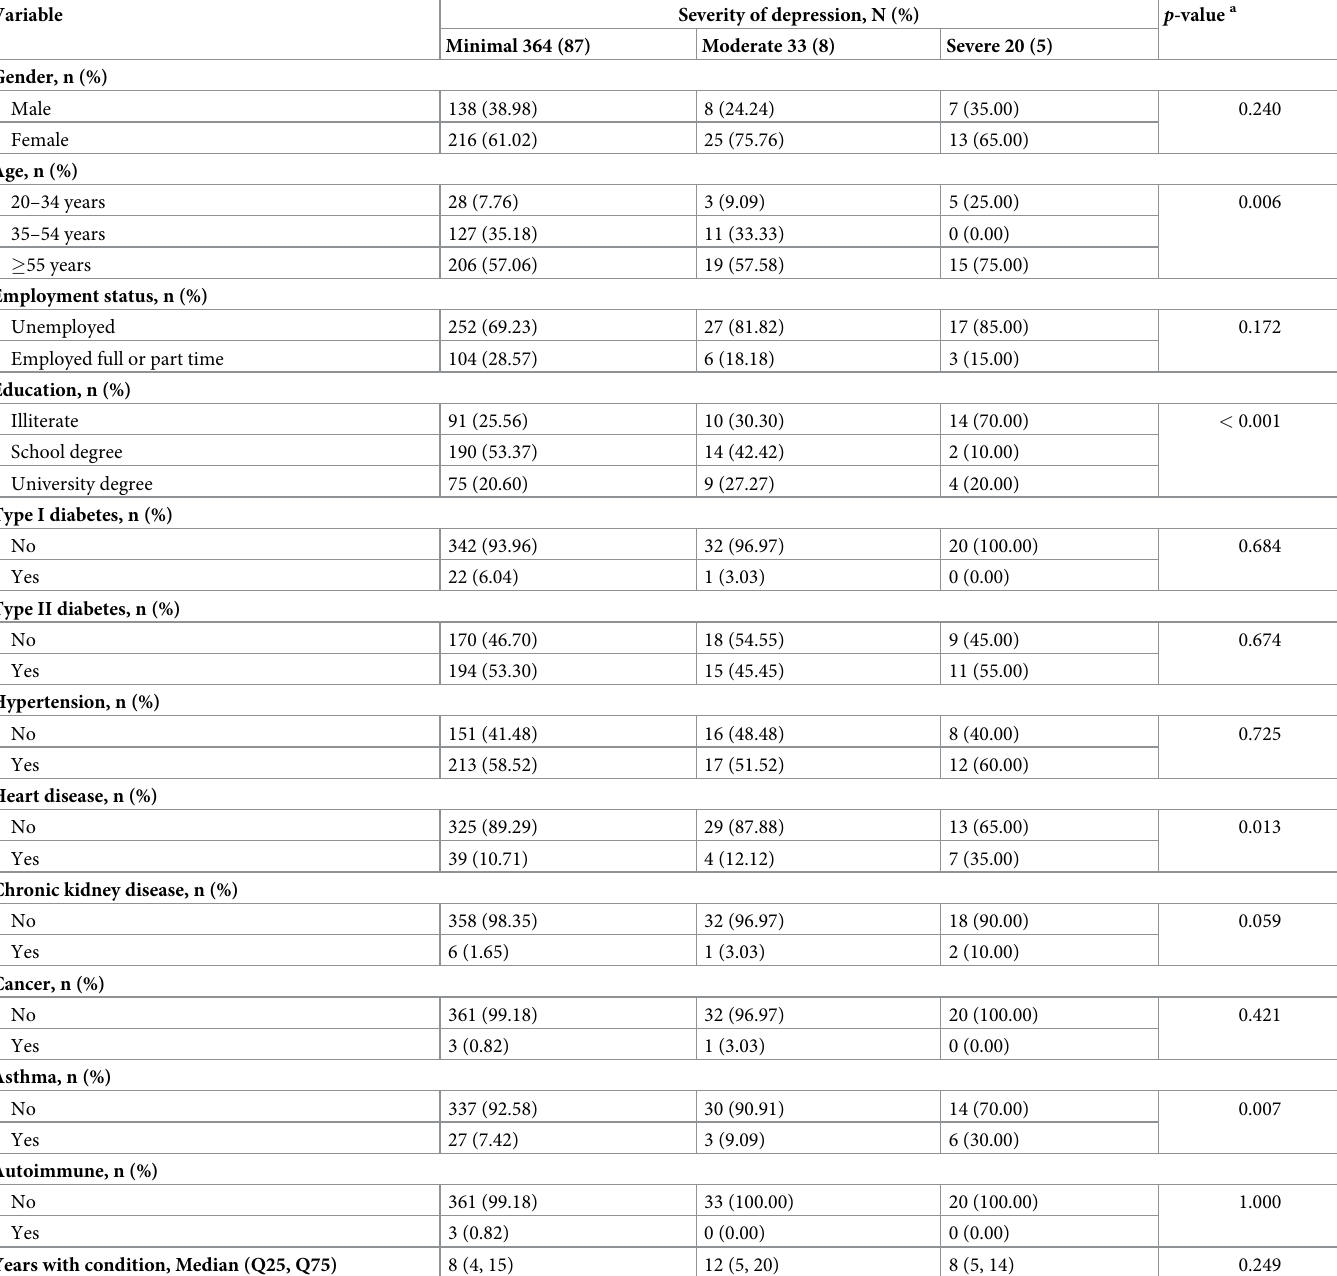
Table 2. Association of depression severity with demographic and comorbidities characteristics of patients with chronic disease in the UAE (N = 417).